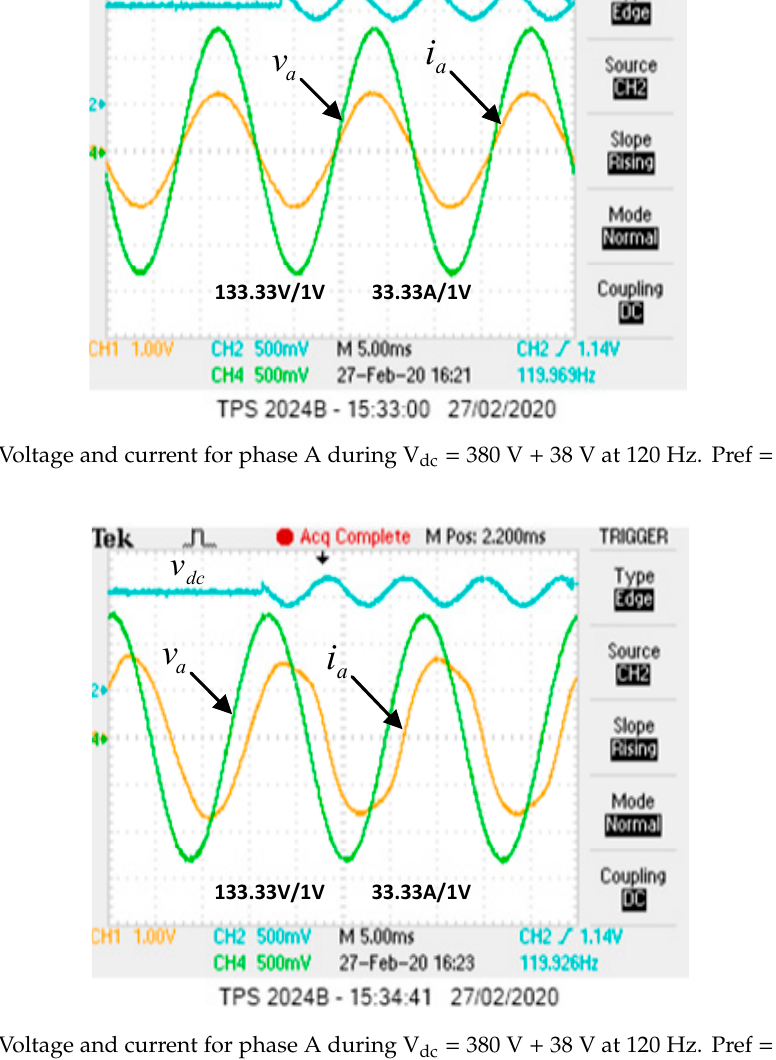
Figure 22. Voltage and current for phase A during V dc = 380 V + 38 V at 120 Hz. Pref = 10 kW and Qref = 10